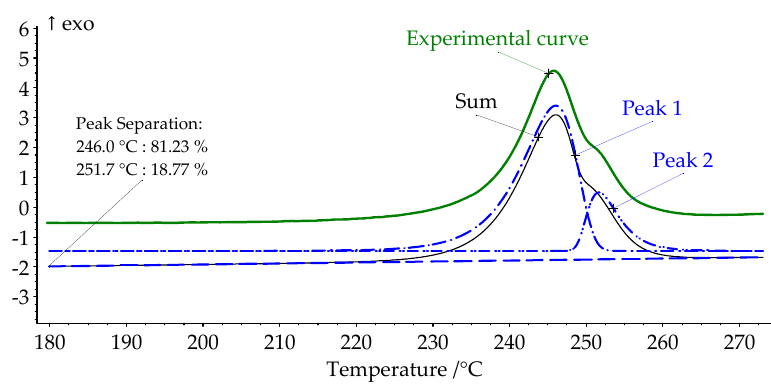
Figure 4. Peak separation for system BB-15.